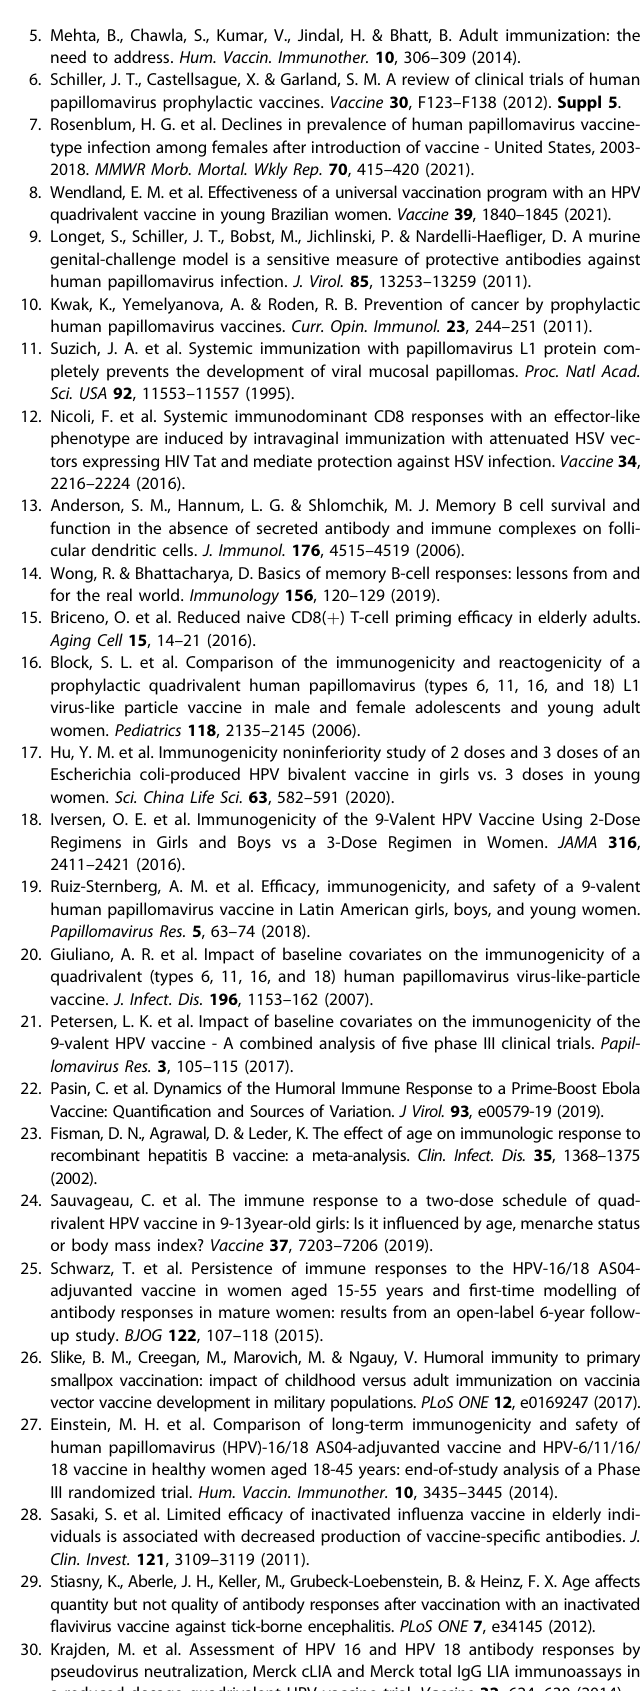
Table 4): eFluor ® 450- α CD4 and PerCP-Cyanine5.5- α CD45RA (all from eBioscience TM -ThermoFisher Scientic); APC- α CD27 and VioBlue ® - α